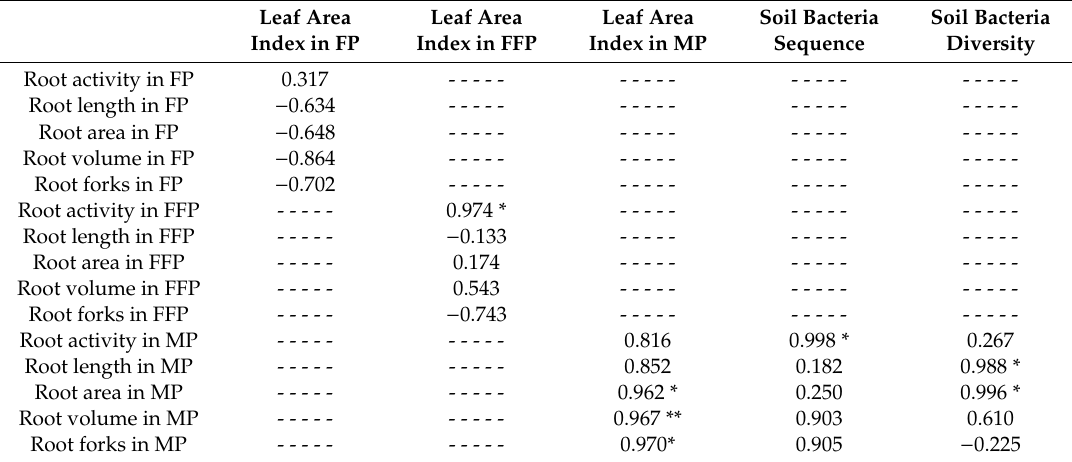
Table 5. Correlation analysis among plant root, plant growth indexes, and soil